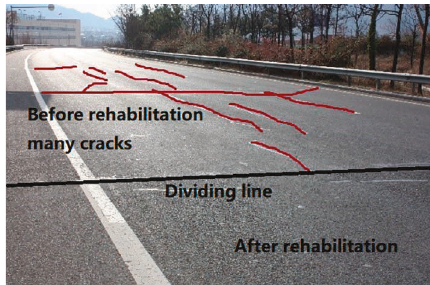
Figure 5: Transverse and longitudinal cracks on the surface of the pavement in the entrance section of the Yangkou tunnel.